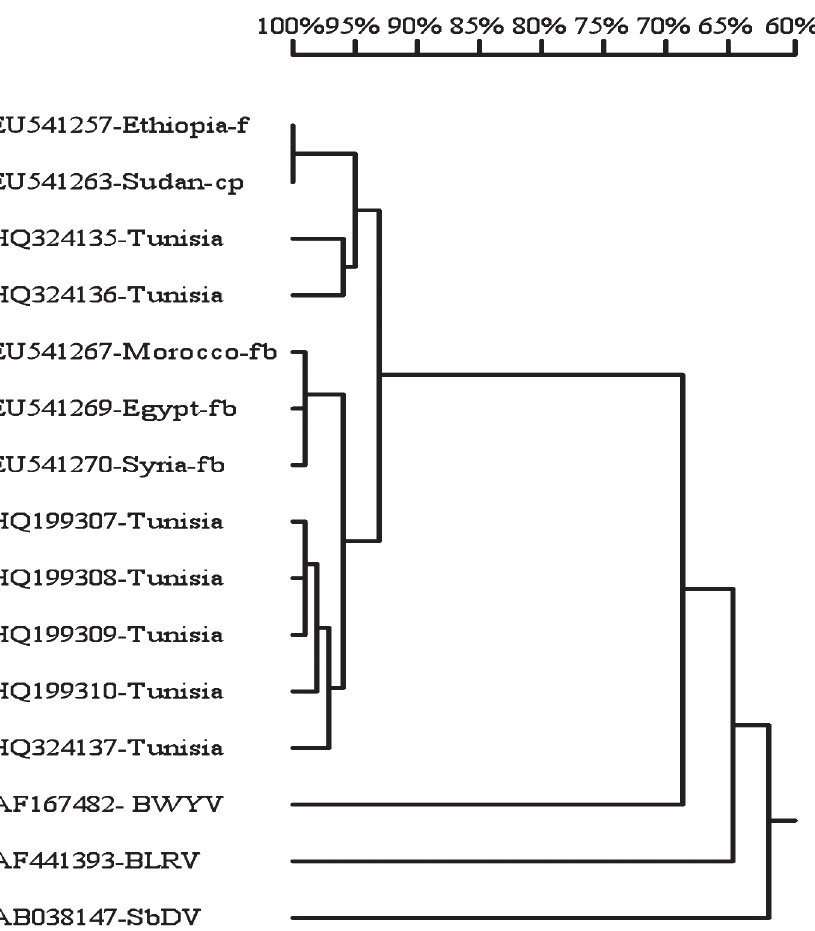
Figure 1. Homology tree deduced from multiple alignments of the CP gene nucleotide sequence of Tunisian, Ethiopi- an, Sudanese, Egyptian, and Syrian isolates of BLRV, BWYV and CpCSV. The tree was constructed using DNAMAN software with 1000 Bootstrap replicates. Values at nodes indicate signi fi cance in bootstrap